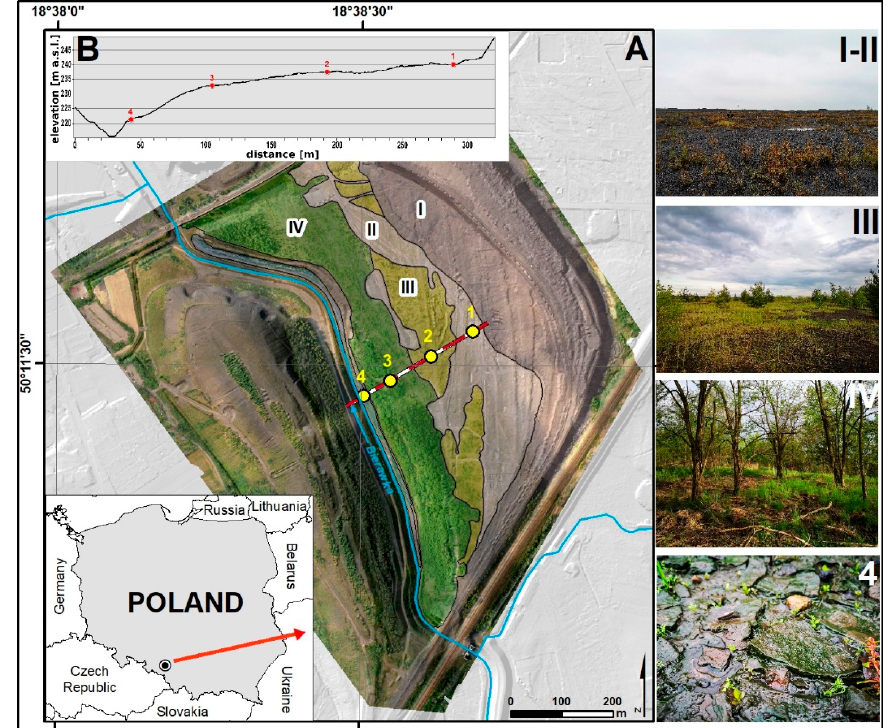
Figure 1. Location of the study area and sampling points: ( A ) (1–4)—soil sampling points and (I–II)—initial stages, III—transition stage, IV—terminal stages, 4—algae crust; ( B ) sampling sites in background of relief.